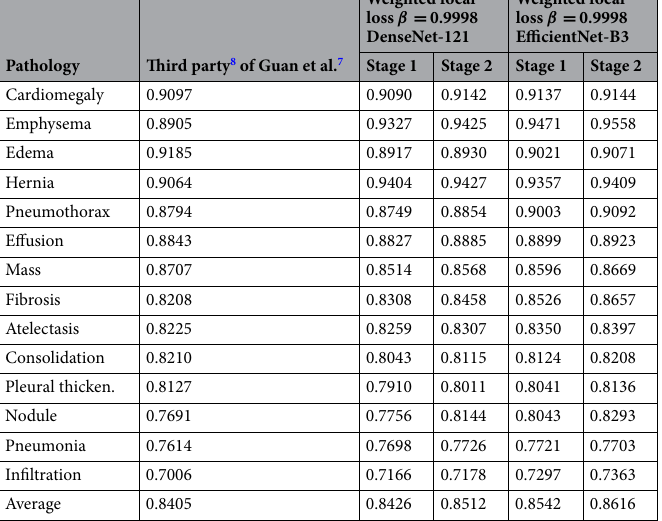
Table 8. Identical split comparison 8 .